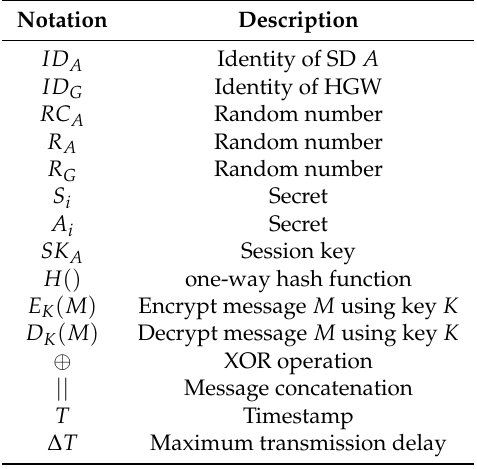
Table 1. Notations and their descriptions used in this